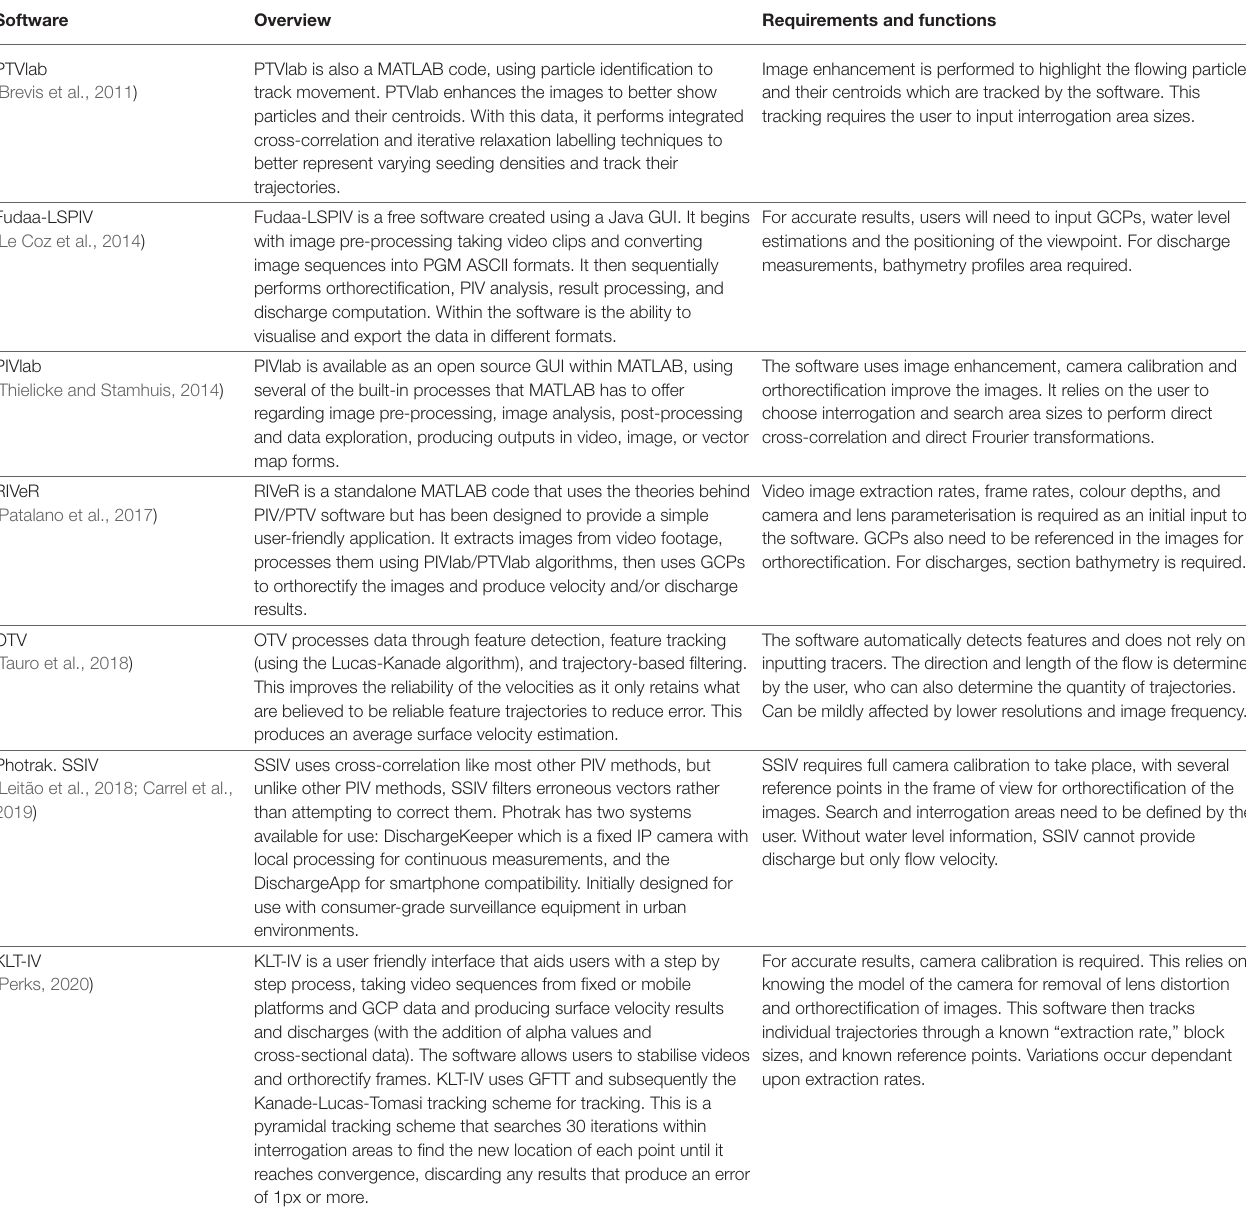
TABLE 1 | A non-exhaustive, generalised, overview of software suites that are currently available with some of their requirements and functions listed. Software